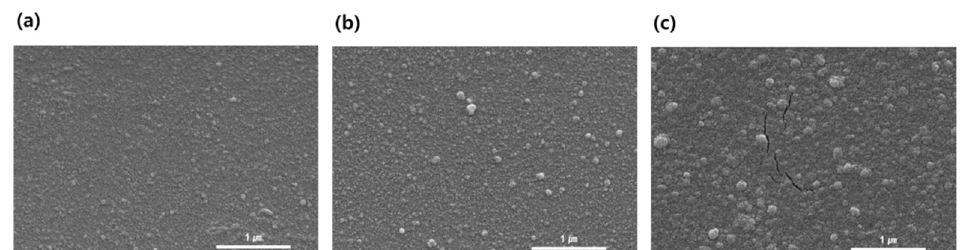
Figure 2. Scanning electron microscopy (SEM) image of tin oxide (SnO 2 ) morphologies deposited by chemical bath deposition (CBD) onto silicon substrates at ( a ) 4, ( b ) 8, and ( c ) 24 h.